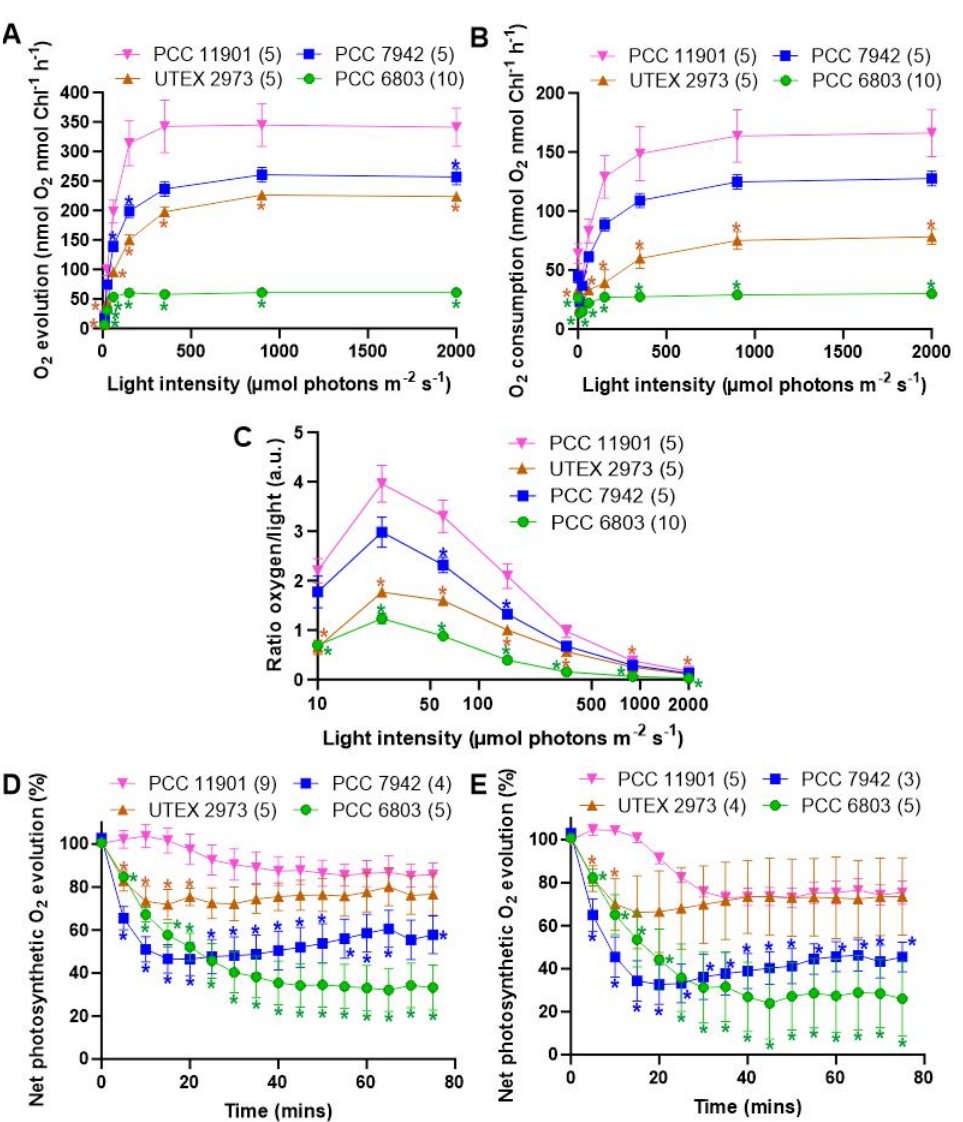
Figure 3. Characterization of the photosynthetic and respiratory rates, light use and photoinhibition of cyanobacterial species . ( A ) Oxygen evolution was measured at different light intensities, and ( B ) oxygen consumption was measured following each light period. ( C ) The coefficient of light use was calculated by dividing the net rate of oxygen evolution by the correspondent light photon flux. Photoinhibition was quantified by determining photosynthetic oxygen evolution in the ( D ) absence and ( E ) presence of lincomycin. All results are from three to ten biological replicates (number indicated in brackets after species legend). Errors bars indicate SE. Color-coded asterisks indicate significant differences between PCC 11901 and the other cyanobacterial species ( p < 0.05).